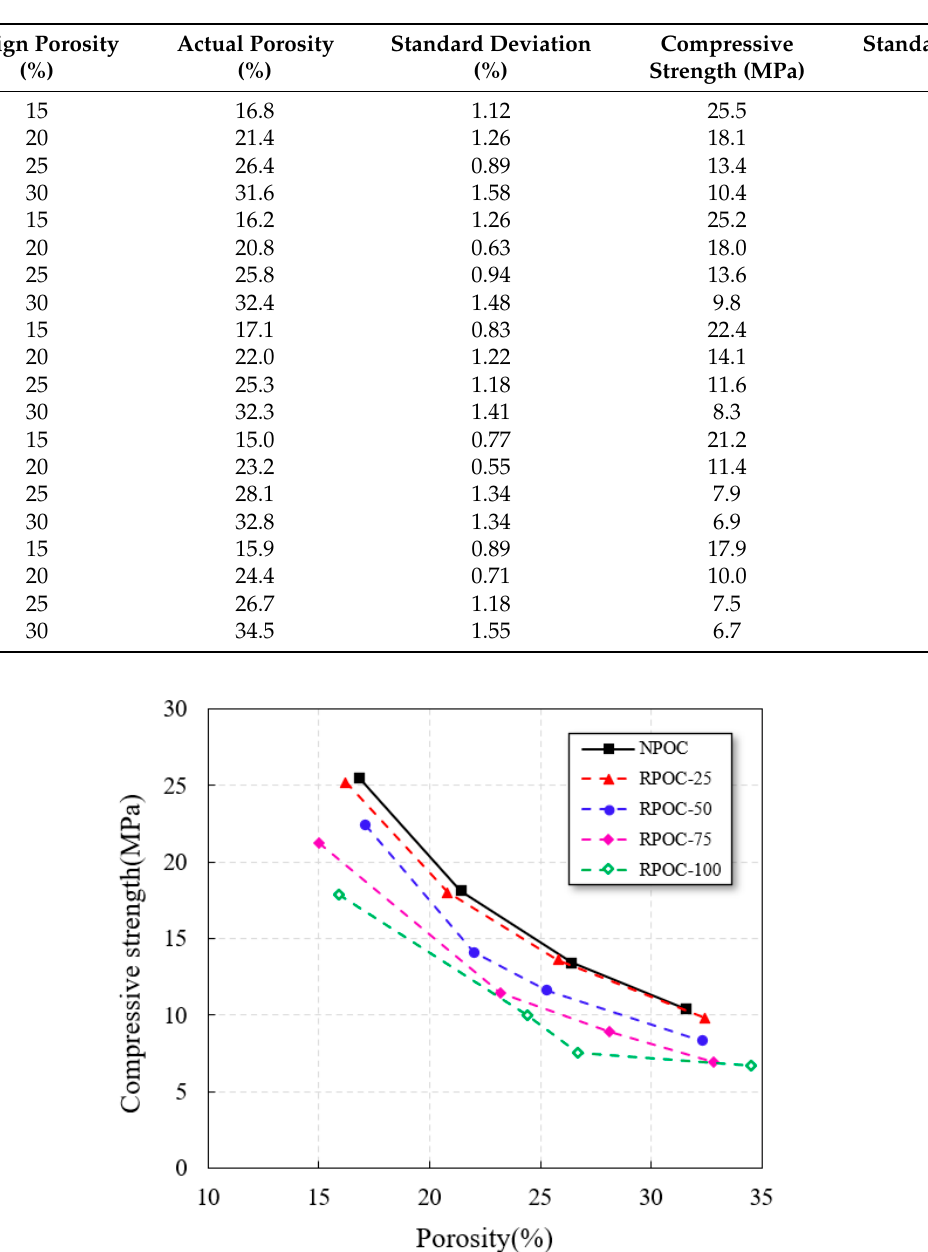
Table 7. Test result.